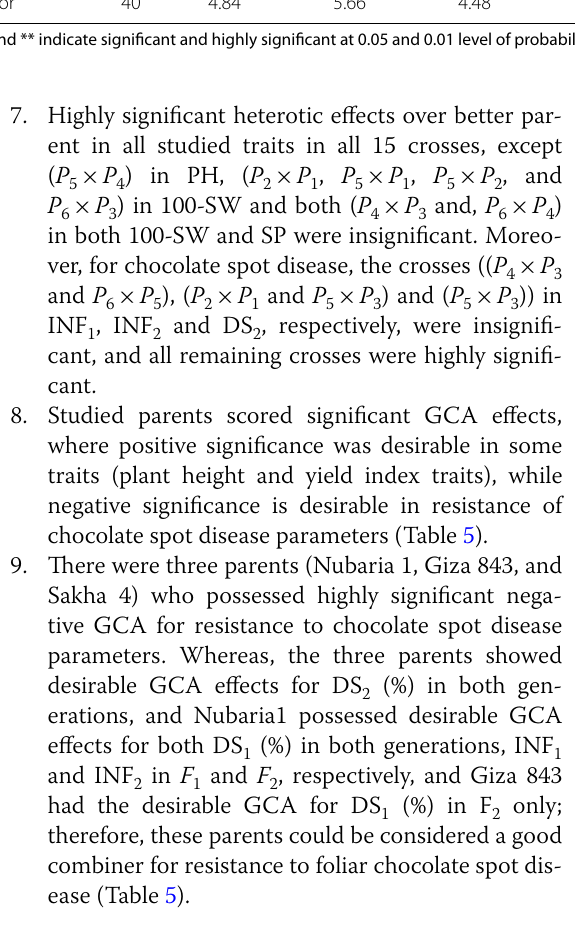
* and ** indicate significant and highly significant at 0.05 and 0.01 level of probability, respectively